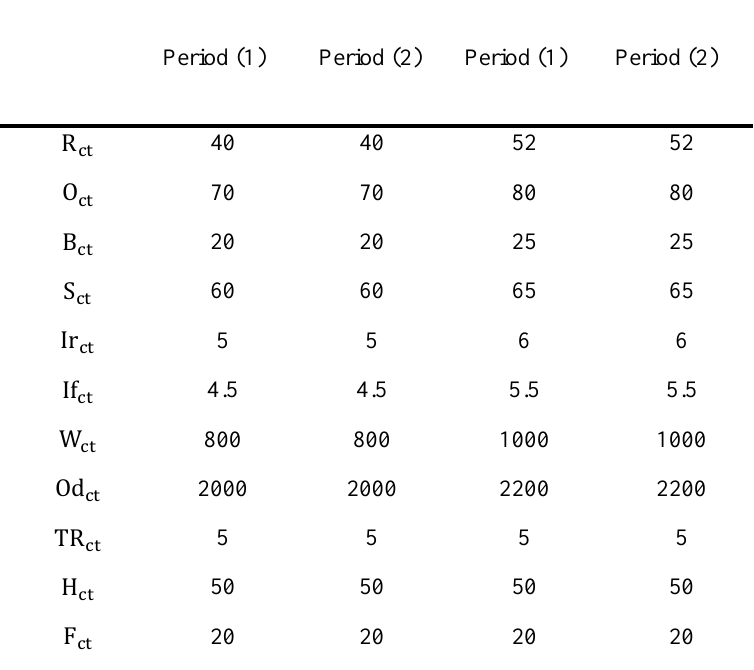
Table 2. List of relevant cost for all decision variables.